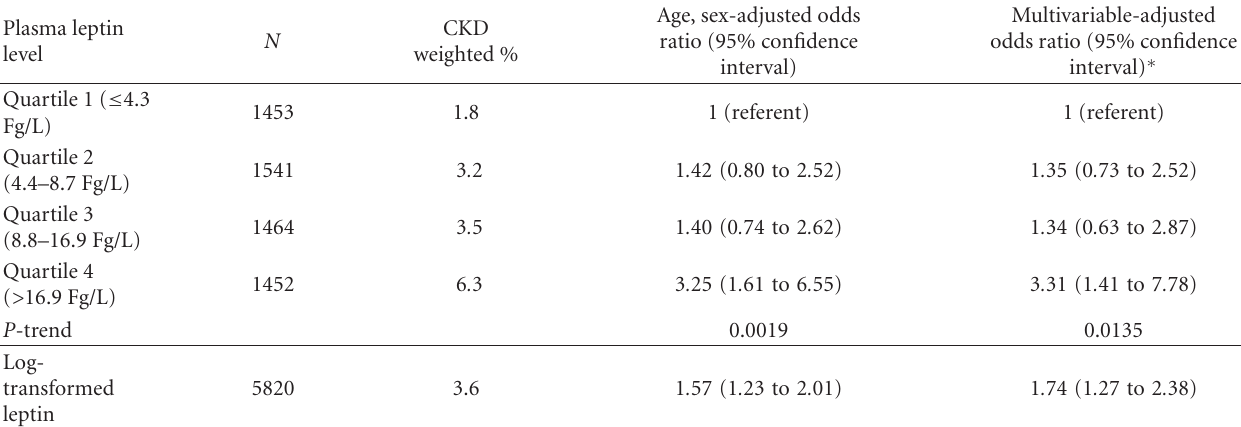
Table 2: Association between plasma leptin level and prevalence of chronic kidney disease (CKD).